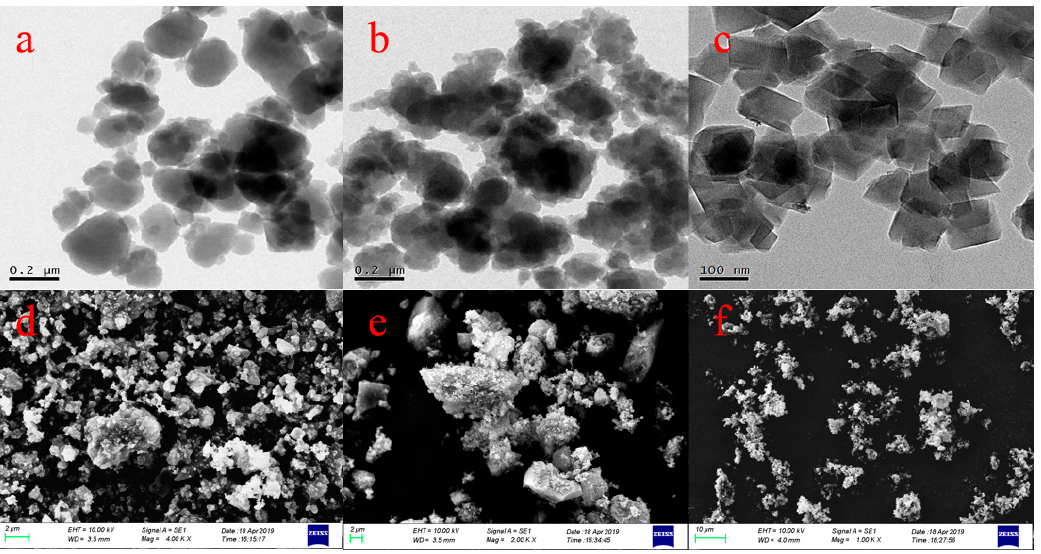
Figure 1. Transmission electron microscopy (TEM) images of ( a ) MIL-100(Fe) ( b ) MIL-100(Cr) ( c ) MIL-101(Cr) and Scanning electron microscopy (SEM) images of ( d ) MIL-100(Fe) ( e ) MIL-100(Cr) ( f ) MIL-101(Cr).